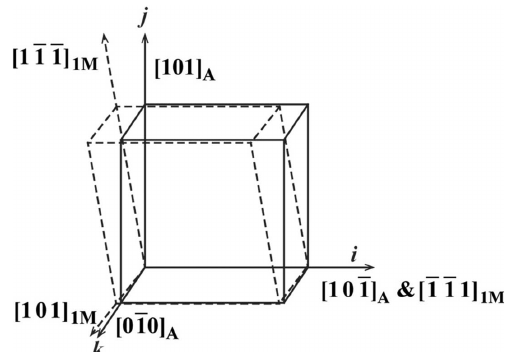
Figure 9 An illustration of the lattice deformation required to achieve the austenite to 7M martensite transformation under the Pitsch relation. The unit cell of austenite and the average unit cell of 7M martensite (referred to as 1M martensite) are outlined by solid lines and dashed lines,